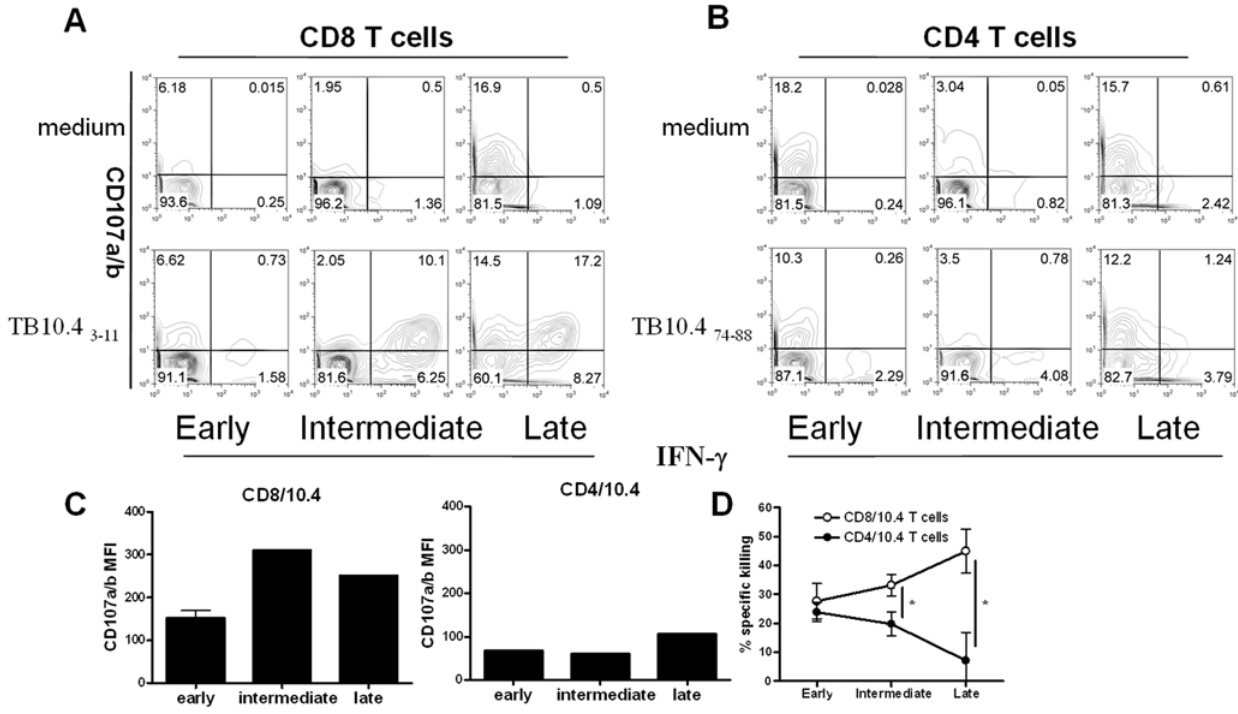
Figure 6. Functional characterization of the CD4/10.4 and CD8/10.4 T cells at different stages of infection. (Early: week 6; Intermediate: week 16, late: week 40) (A and B) Lung cells from infected mice were stimulated in vitro with TB10.4 3–11 or TB10.4 74–88 (lower panel) or left non stimulated (‘‘Media’’, upper panel) in the presence of a CD107a/b and stained with a IFN- c and a CD8 (A), or a CD4 (B), antibodies (C) CD107a/b MFI of the IFN- c positive cells following in vitro stimulation with TB10.4 3–11 or TB10.4 74–88 . (D) The specific lysis of TB10.4 3–11 or TB10.4 74–88 loaded cells was determined in an in vivo cytotoxicity assay. Unloaded splenocytes (CFSE low ) and TB10.4 3–11 or TB10.4 74–88 loaded splenocytes (CFSE high ) from naı¨ve mice were transferred into infected mice. The amount of splenocytes killed in vivo by cytotoxic T cells specific for either TB10.4 3–11 or TB10.4 74–88 was observed as a reduction in the CFSE high population and a percent specific lysis was calculated. A value of P , 0.05 (students paired t- test) was considered significant and is shown by